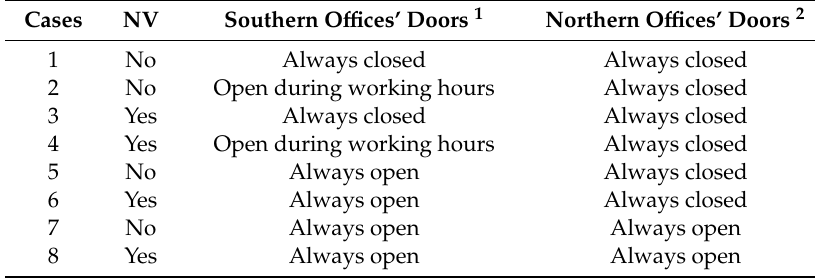
Table 6. Di ff erent schemes of open or closed doors with / without NV with NVR = 1.66 ACH (cases are without active cooling).